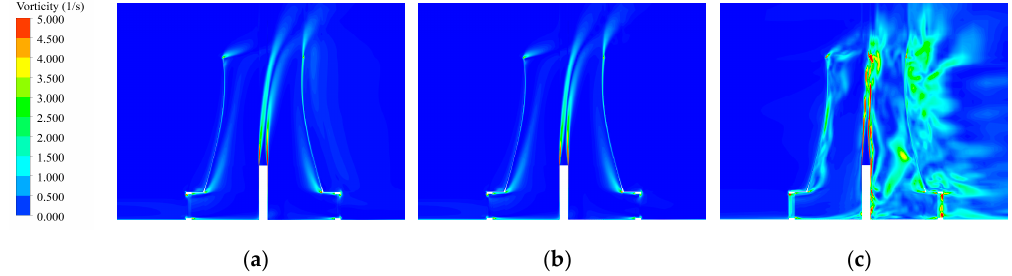
Figure 11. Comparisons of instantaneous vorticity magnitude distribution at vertical plane (y = 0 m) in NDDCT with flue gas injection: ( a ) RANS; ( b ) URANS; ( c ) LES.